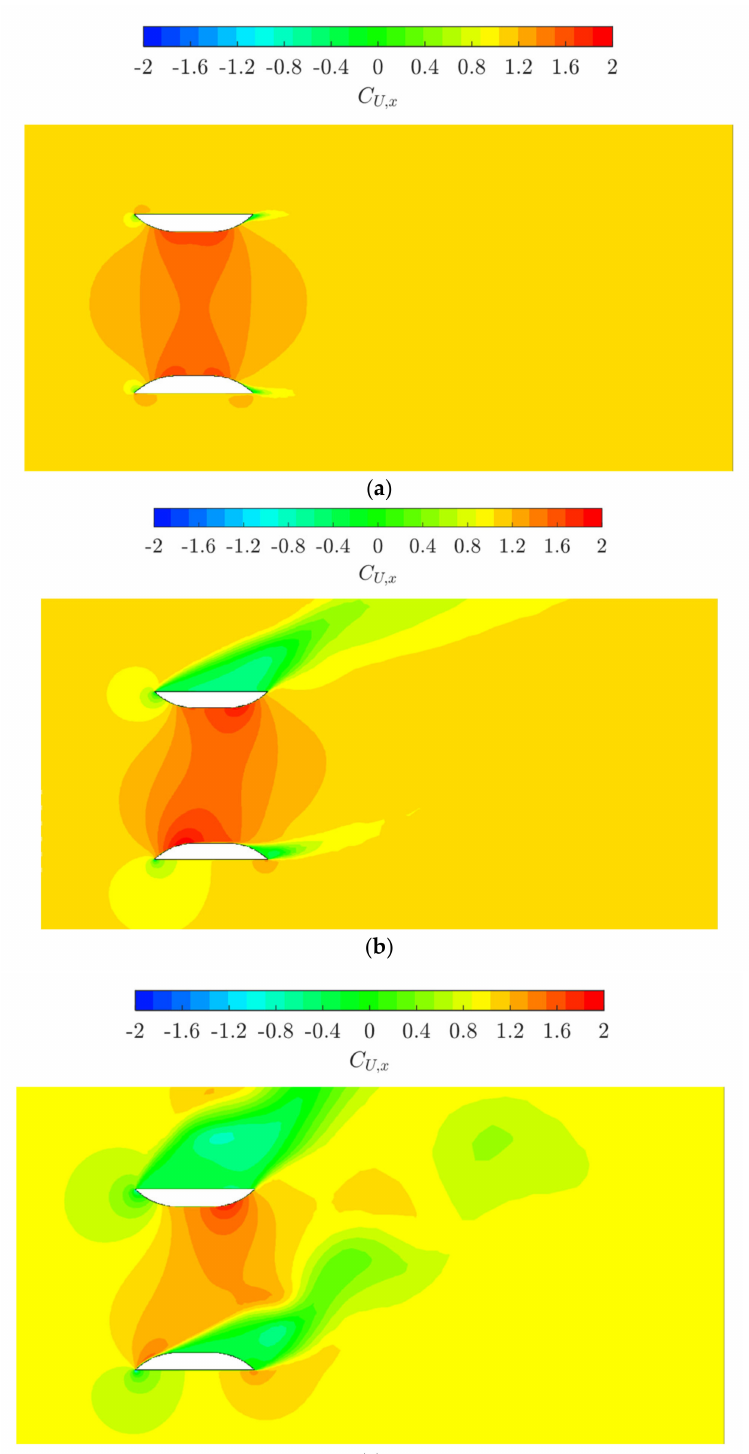
Figure 12. Illustrative cross-sectional representation of the axial velocity coefficient ( C U , x ) within the duct domain at distinct yaw angles ( U ∞ = 4 m.s − 1 ). ( a ) γ = 0 ◦ ; ( b ) γ = 23.2 ◦ ; ( c ) γ = 38 ◦